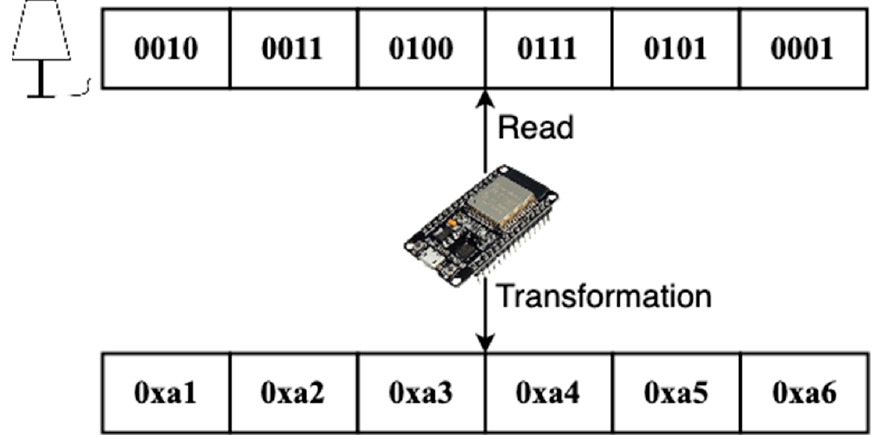
Figure 4. Schematic diagram of converting binary data to the hexadecimal format.